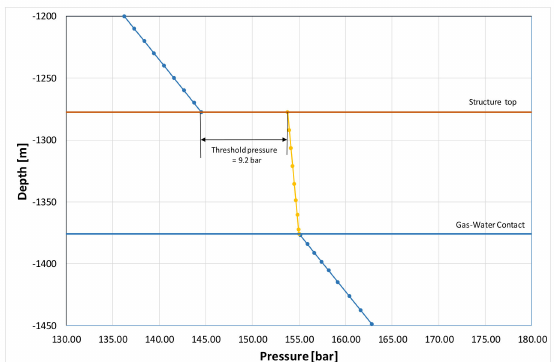
Figure 29. Diagram for the estimation of the threshold displacement pressure at the caprock–reservoir rock boundary under initial conditions.